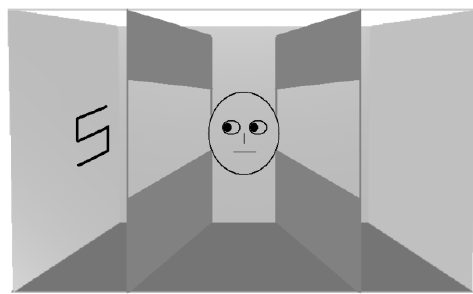
Figure 4. One of the stimuli employed by Cole et al. [19].